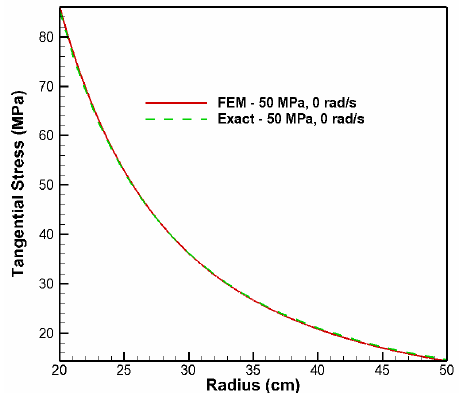
Figure 19. Radial stress under 𝑞